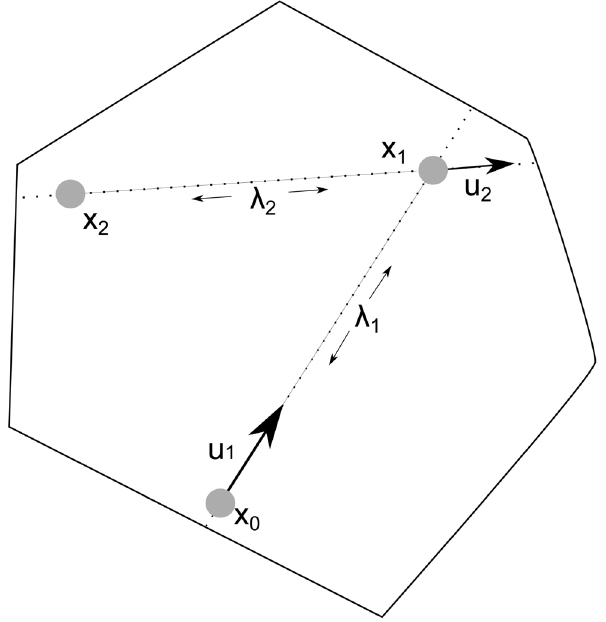
Figure 1. Illustration of hit-and-run. Hit-and-run starts at the point x 0 in the solution space S . It chooses a random direction u 1 and determines the maximum distance it can travel forwards or backwards in that direction. A random step size l 1 is chosen on the line u 1 [ S . The next point x 1 is obtained by travelling l 1 in the direction u 1 . By iterating this process T times, samples are obtained that are uniformly distributed in the space, when T ? ?